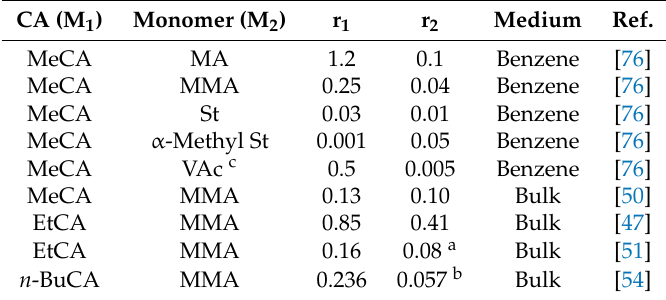
Table 6. Reactivity ratios of CAs with vinyl monomers at 60 ◦